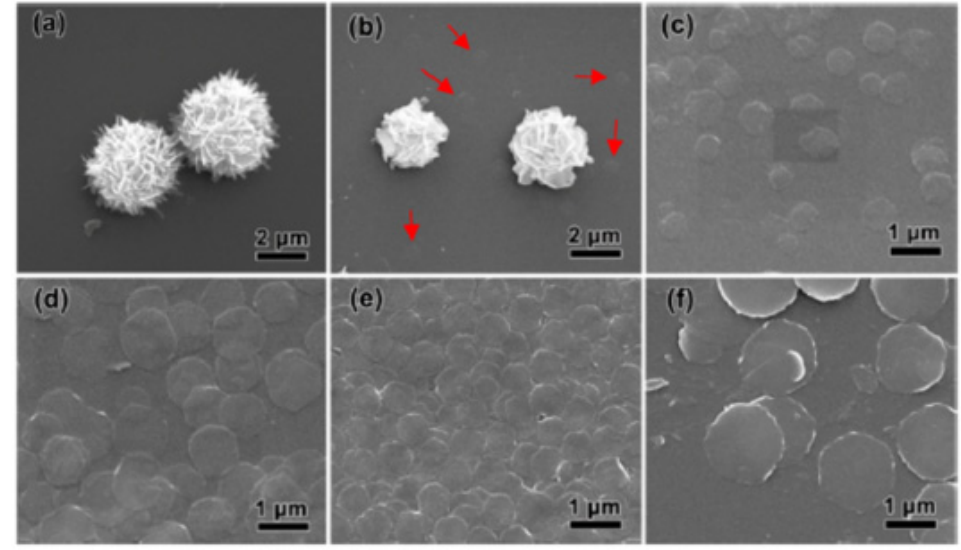
Figure 18. SEM images of the SnS 2 samples prepared at different reaction times. ( a ) 1 h; ( b , c ) 2 h; ( d ) 5 h; ( e ) 12 h; and ( f ) 24 h. Reproduced with permission from [38].